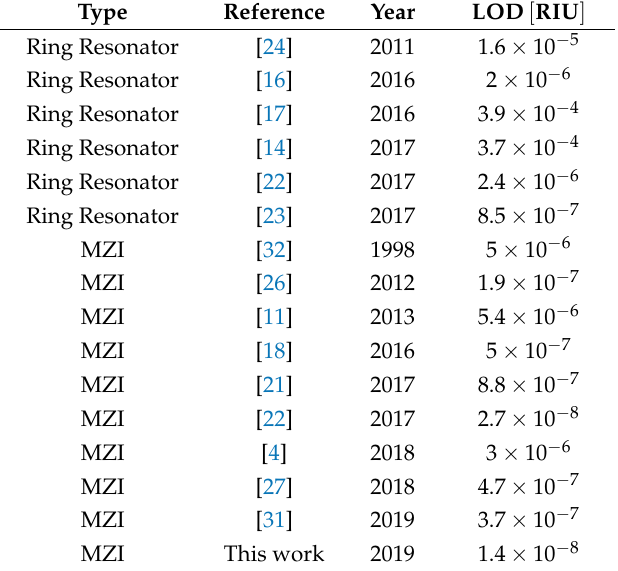
Table 2. Comparison of bulk LOD values achieved with recent resonant and interferometric photonic